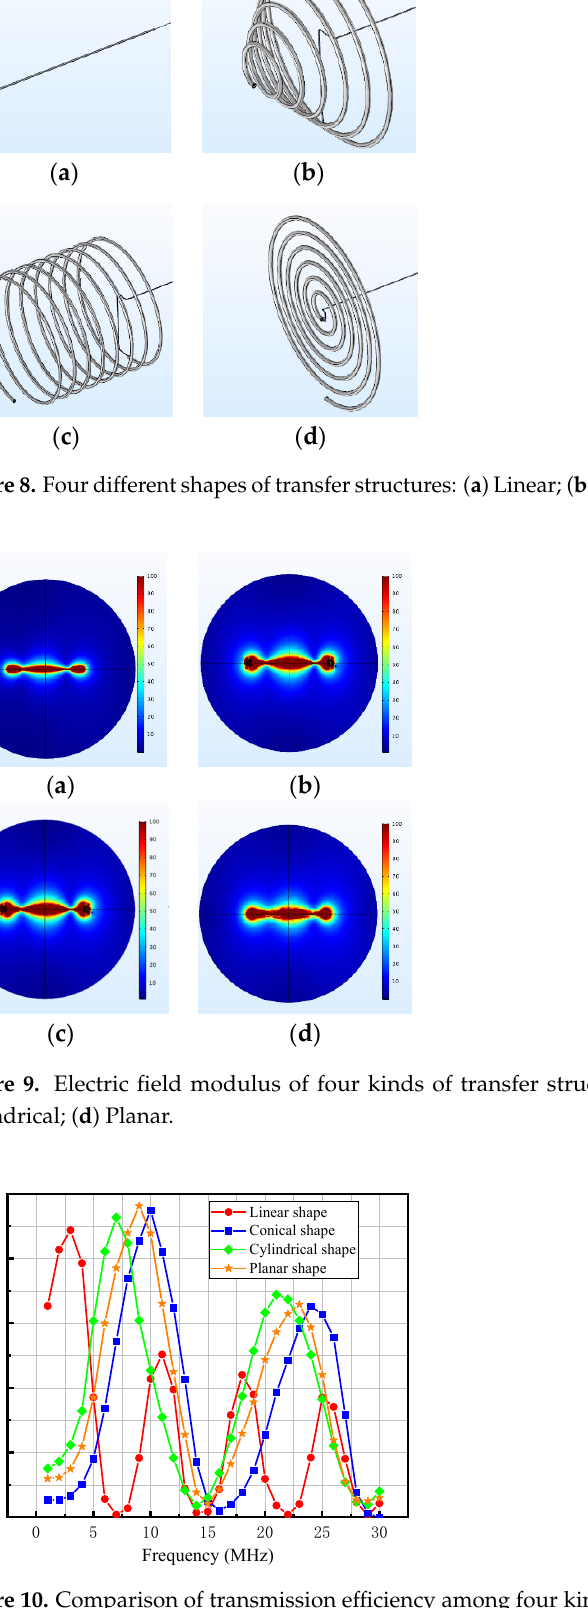
Figure 10. Comparison of transmission efficiency among four kinds of transfer structures.